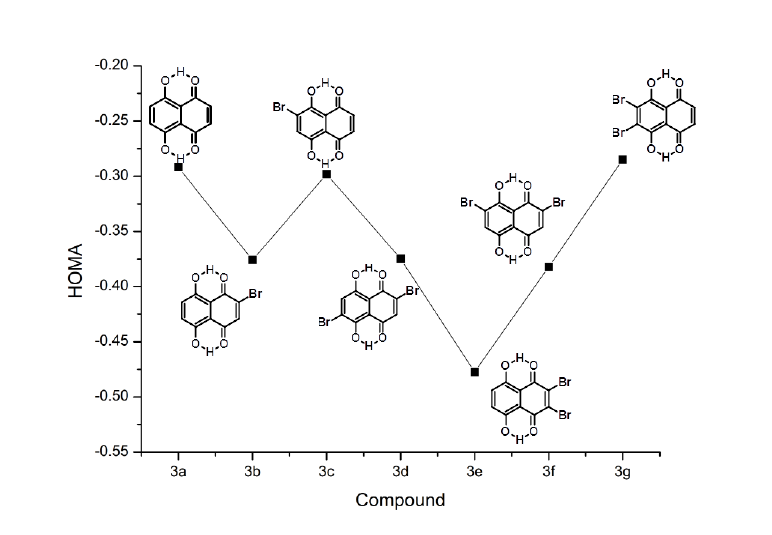
Figure 4. The HOMA aromaticity index evolution of the quinoid ring as a result of substitution by –Br and hydroxyl groups in the compounds of group 3